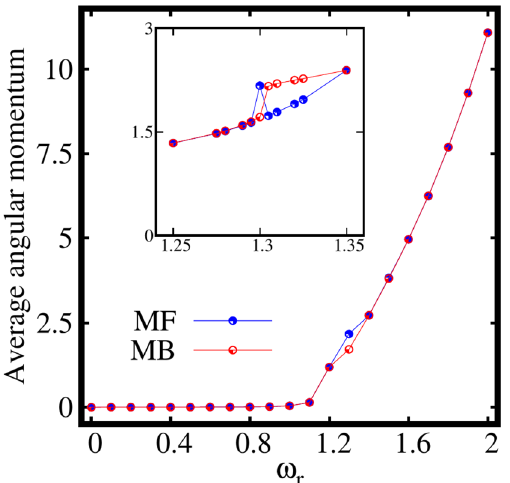
Figure 4. Expectation value of angular momentum operator �ˆ L Z � / N , computed at the mean-field (MF) and many-body (MB) levels [with M = 1 and M = 4 self-consistent orbitals, respectively] as a function of the rotation frequency ω r for the elongated trap. Actual data are points. The continuous curves are only to guide the eye. All quantities shown are